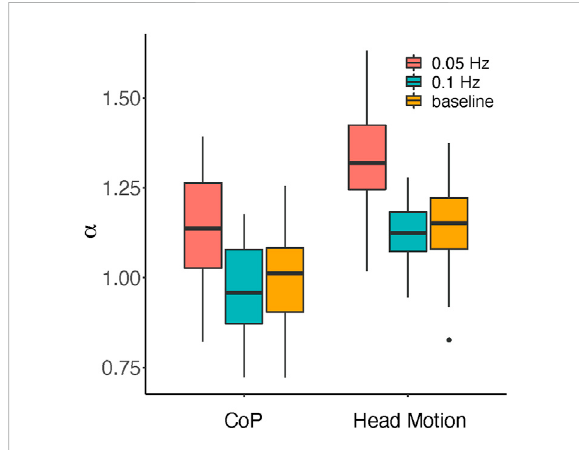
FIGURE 4 The α exponent values for each condition of measurement and direction-change